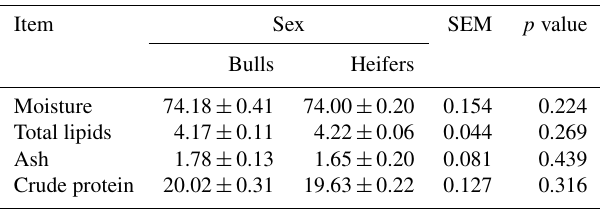
Table 2. Chemical composition (grams per 100g of muscle) of Longissimus lumborum muscle of feedlot cattle finished with a whole shelled corn diet. Note that SEM is the standard error of the mean.